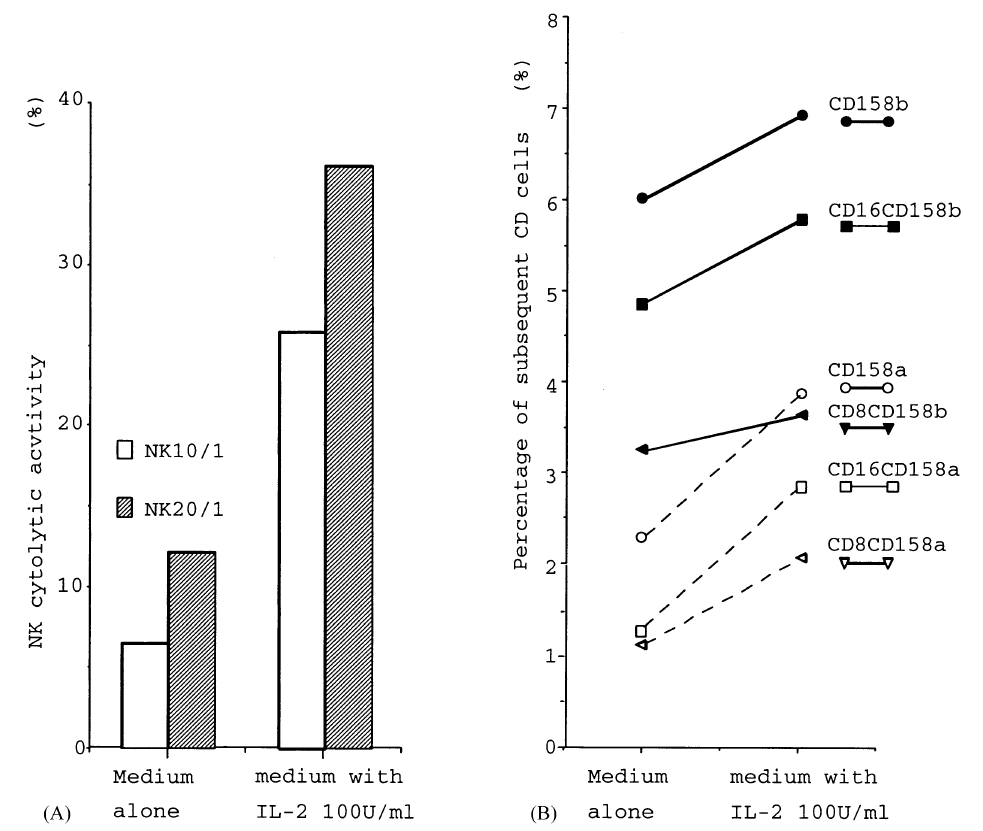
FIG. 2. The change of CD158a/b expression and NK activity when lymphocytes are treated with medium alone or medium containing IL-2 at 100 U/ml. Eight of 35 donors were assessed for CD158a/b expression and NK cytolytic activity. (A) NK cytolytic activity in bars representing medium alone and medium with IL-2. (B) Six lines presenting the percentage increase of subsequent CD cells. The percentage of each CD cell was increased significantly by the treatment of IL-2. The change of each CD cell was in parallel to the increase of NK